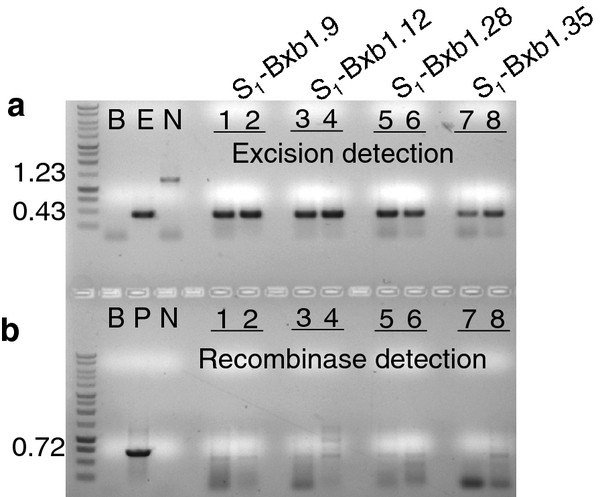
PCR analysis for site-specific recombination and the presence of the recombinase gene in the selfed (S1) generation. PCR reactions (a) with primers e and f or (b) with primers g and h on representative plant DNAs. a, b) Selfed lines (lanes 1, 2) S1-Bxb1.9; (lanes 3, 4) S1-Bxb1.12; (lane 5, 6) S1-Bxb1.28; (lane 7, 8) S1-Bxb1.35 positive for excised target but the Bxb1 transgene is absent. Control lanes are B (blank, no DNA); E (excision, pN6-Bxb1exc DNA); N (no excision, pN6-Bxb1); P (pCOXS3-Bxb1).